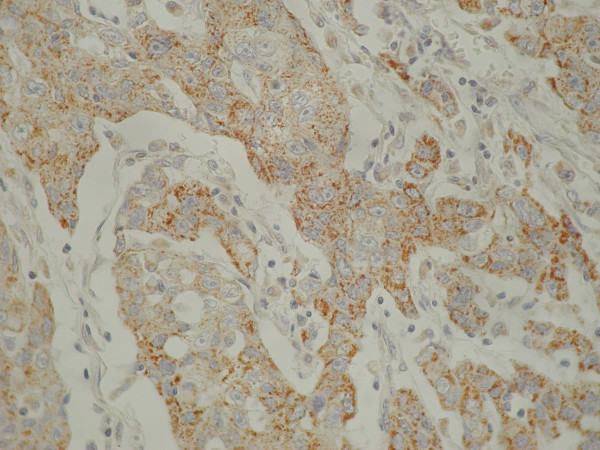
Strong cytoplasmic immunohistochemical staining of tumor cells for VEGF in a CUP case. It is shown the characteristic granular cytoplasmic staining pattern and the occasionally weak positive reaction of intervening stromal and endothelial cells (original magnification ×200, counterstained with hematoxylin)